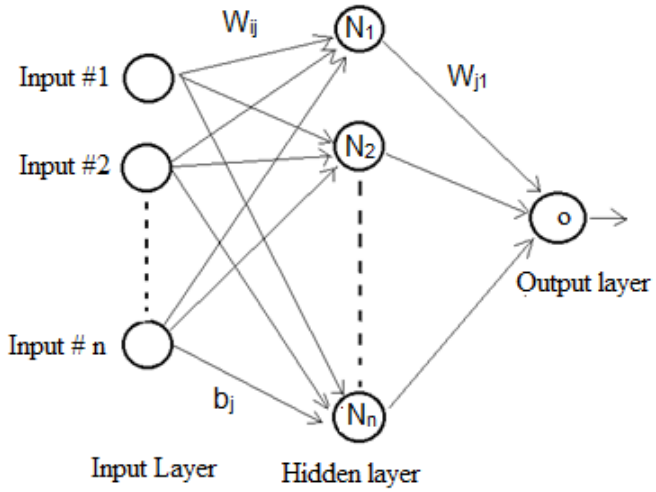
Figure 2. Artificial neural network structure